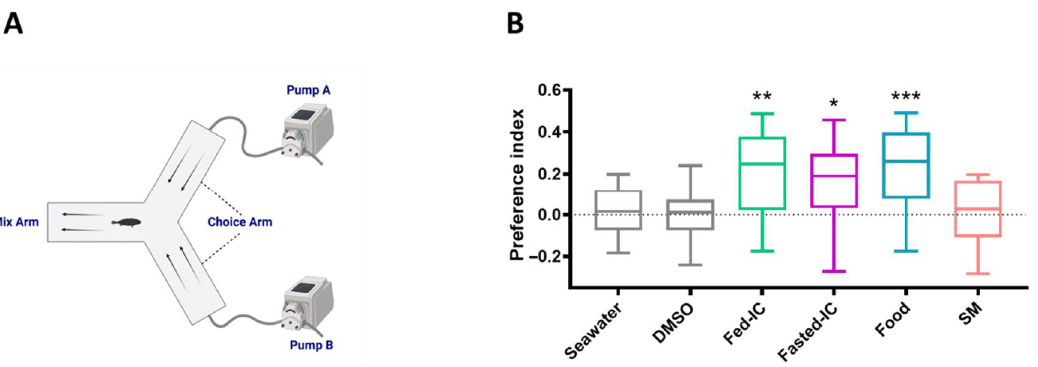
Figure 1. Behavioral responses to conspecific body fluids. ( A ) Schematic diagram of the Y-maze choice apparatus. The fish could freely explore each arm and the mixing zone. Pumps A and B established identical flow rates, and the delivery of solutions with different odorants was established in the choice arms. The arrows show the direction of flow. ( B ) The behavioral responses of large yellow croaker to intestinal contents (ICs) with regular feeding (Fed-ICs, represented by green box), ICs after a 24 h fast (Fasted-ICs, represented by purple box), food (commercial pellet feed, represented by blue box), and skin mucus (SM, represented by orange box). The preference index for an odorant is presented as the mean ± S.E.M.; n = 20. Student’s t -test was used to analyze all treatment data versus the seawater control data. * p < 0.05, ** p < 0.01, *** p < 0.001.